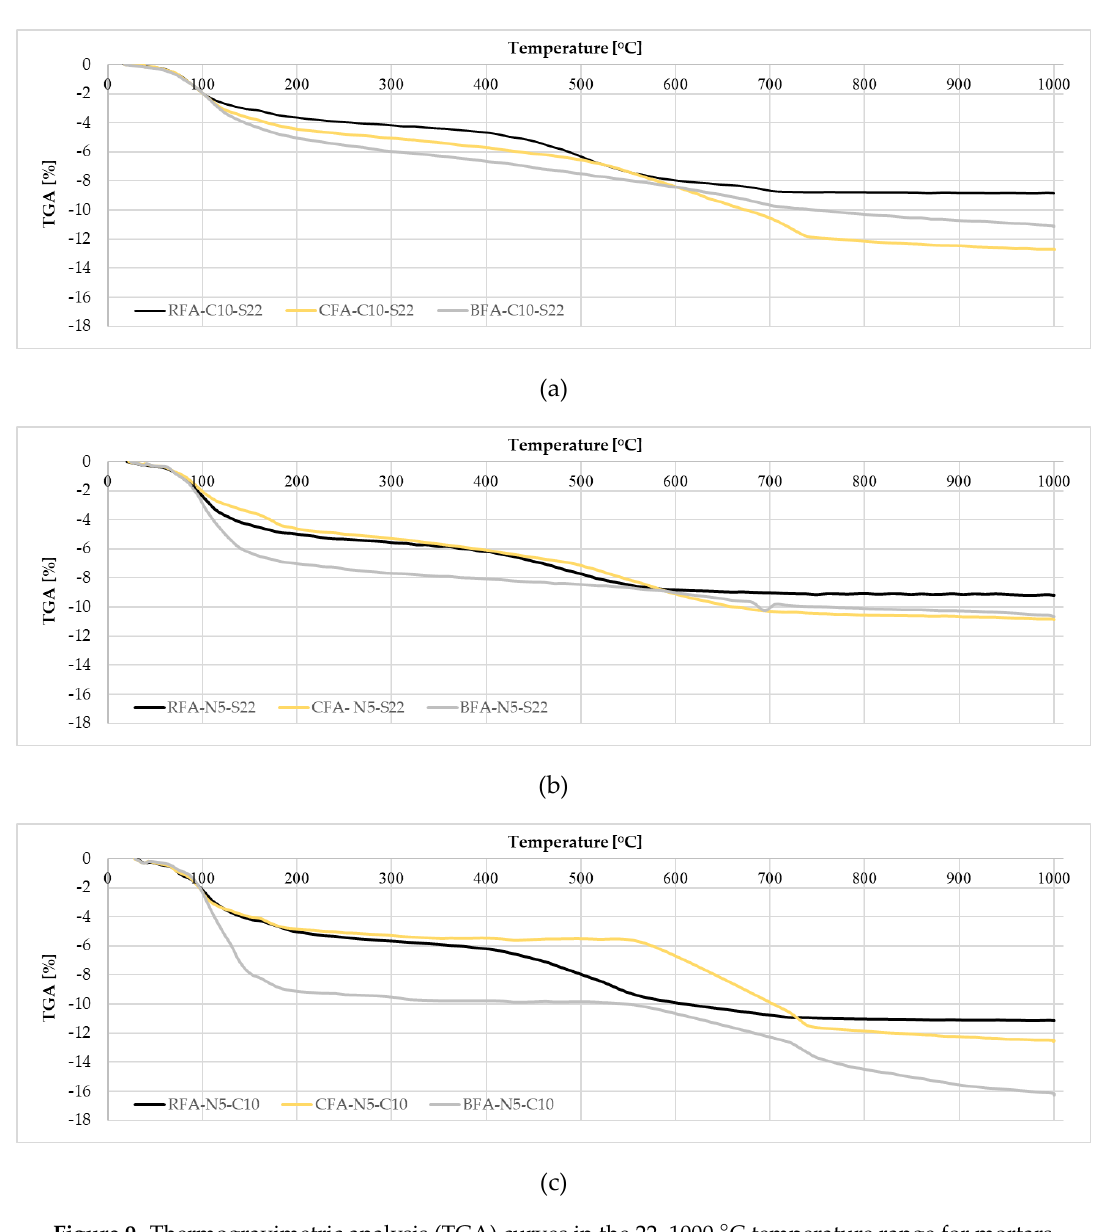
Figure 9. Thermogravimetric analysis (TGA) curves in the 22–1000 °C temperature range for mortars activated with: ( a ) C10-S22, ( b ) N5-S22, and ( c ) N5-C10.